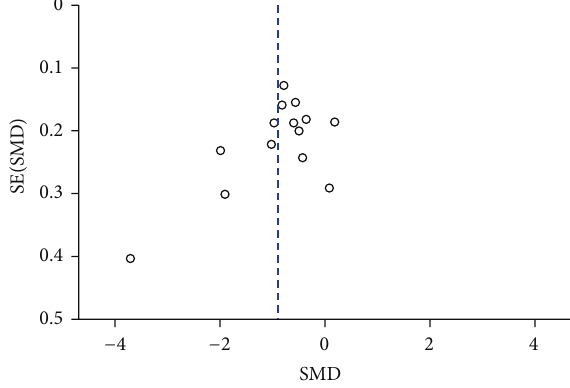
Figure 13: Funnel plot of CSF 𝛼 -syn levels in PD compared to